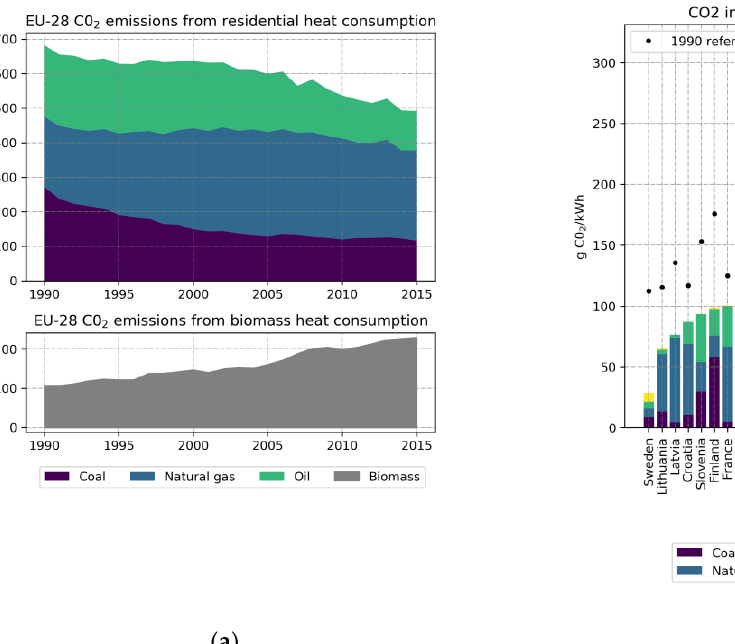
Figure 3. ( a ) Historical development of CO 2 emission from residential heating PES from 1990 to 2015 for the EU-28 MSs. CO 2 emissions from non-renewable waste incineration are not included in the figure as they only account for ~3 ‰ of EU-28 CO 2 emissions. Biomass includes only direct emissions and not for example uptake in the LULUCF sector or from direct and indirect land-use change. ( b ) Average g CO 2 per kWh heat used per MS in 2015 with 1990 as a reference level. Results are ranked from lowest average CO 2 intensity to highest in 2015.